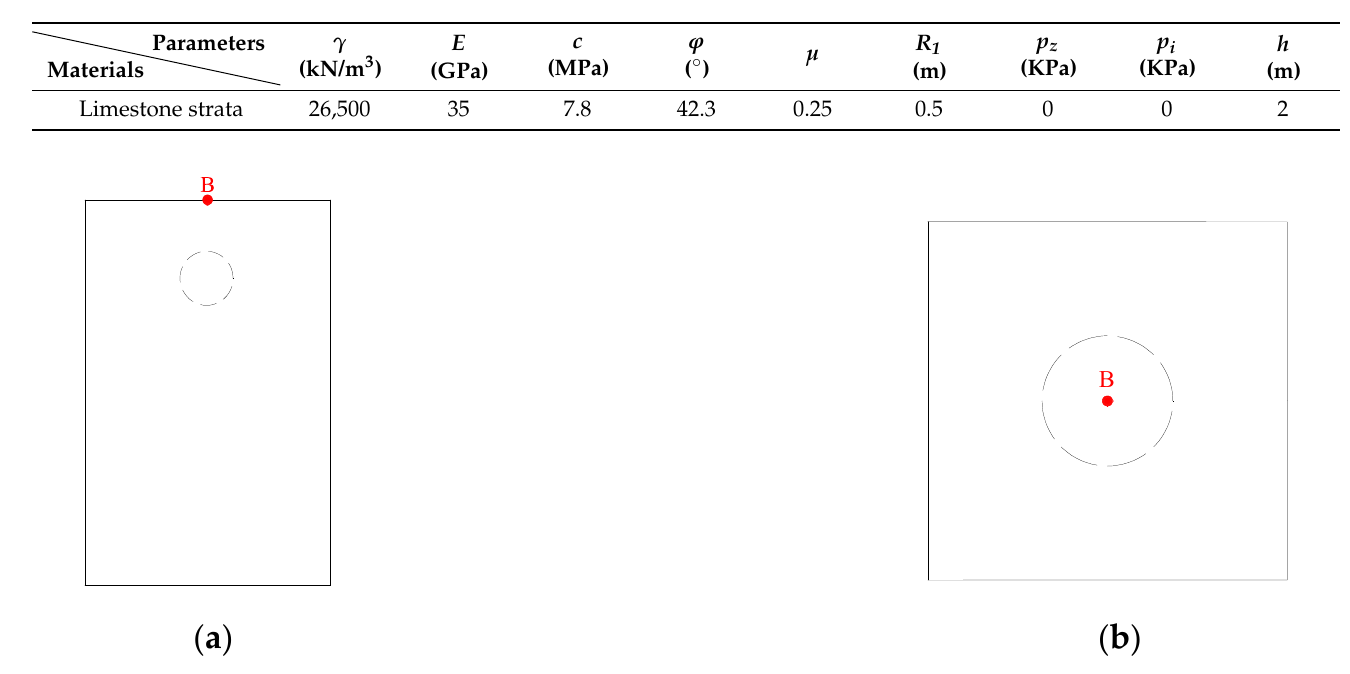
Table 2. Applied load and corresponding subside of the critical point. Figure 9. Sketch of monitored point layout. ( a ) vertical cross-section; ( b ) horizontal cross-section. Table 1. The spatial geometry parameter and the attribute parameter.